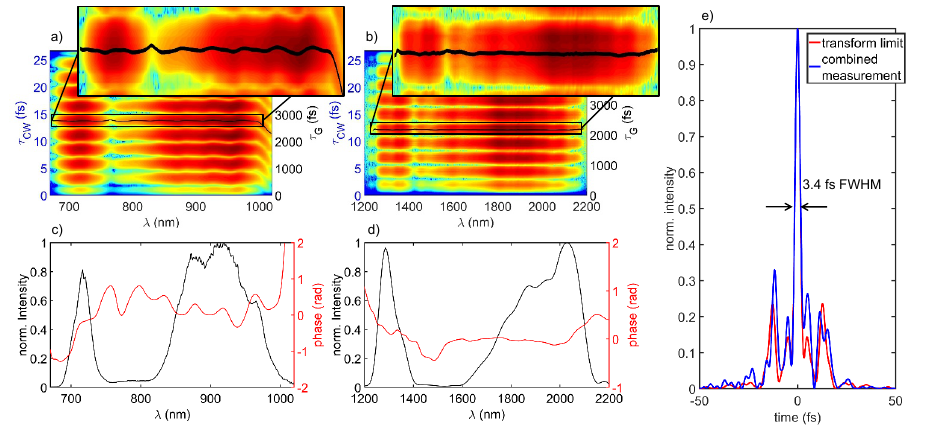
Figure 1. 2DSI traces of NIR (a) and IR (b) OPA with the cw delay of the ancillary pulse on the left y-axis and the retrieved group delay overlayed on the right y-axis. The spectra and spectral phases are shown in (c) and (d) resulting in 6.6 fs and 7.2 fs FWHM duration. The calculated FWHM of the synthesized pulse yields 3.4 fs (e) for perfect temporal overlap at time